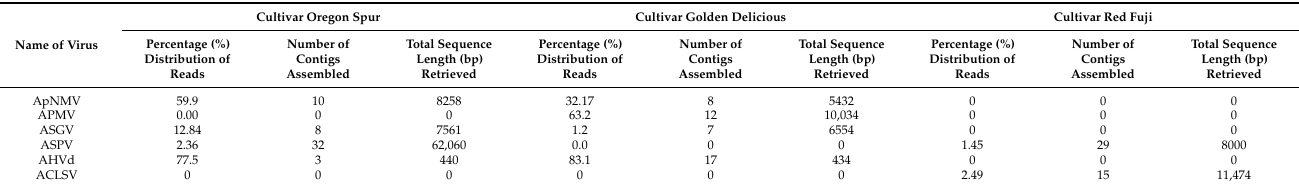
Table 2. Percentage distribution of individual viral reads, number of contigs obtained from each virus and total sequence length retrieved from two cultivars of Oregon Spur and Golden Delicious after RNA-Seq.